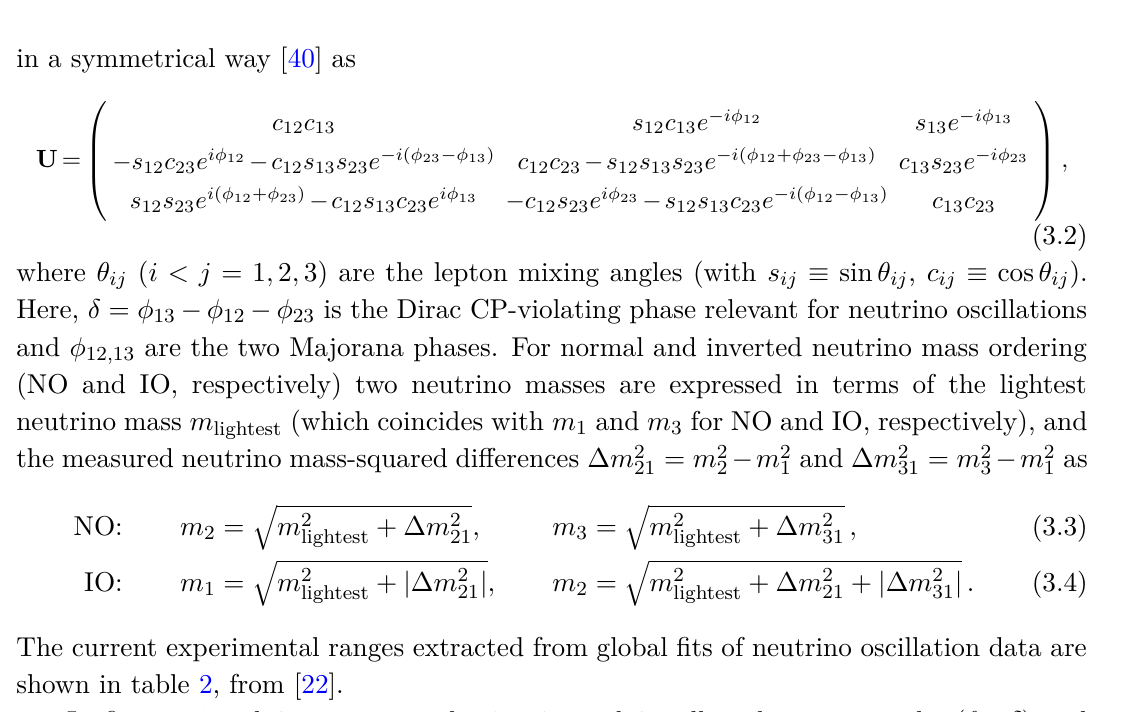
Table 2 . Neutrino oscillation parameters obtained from the global analysis of ref.